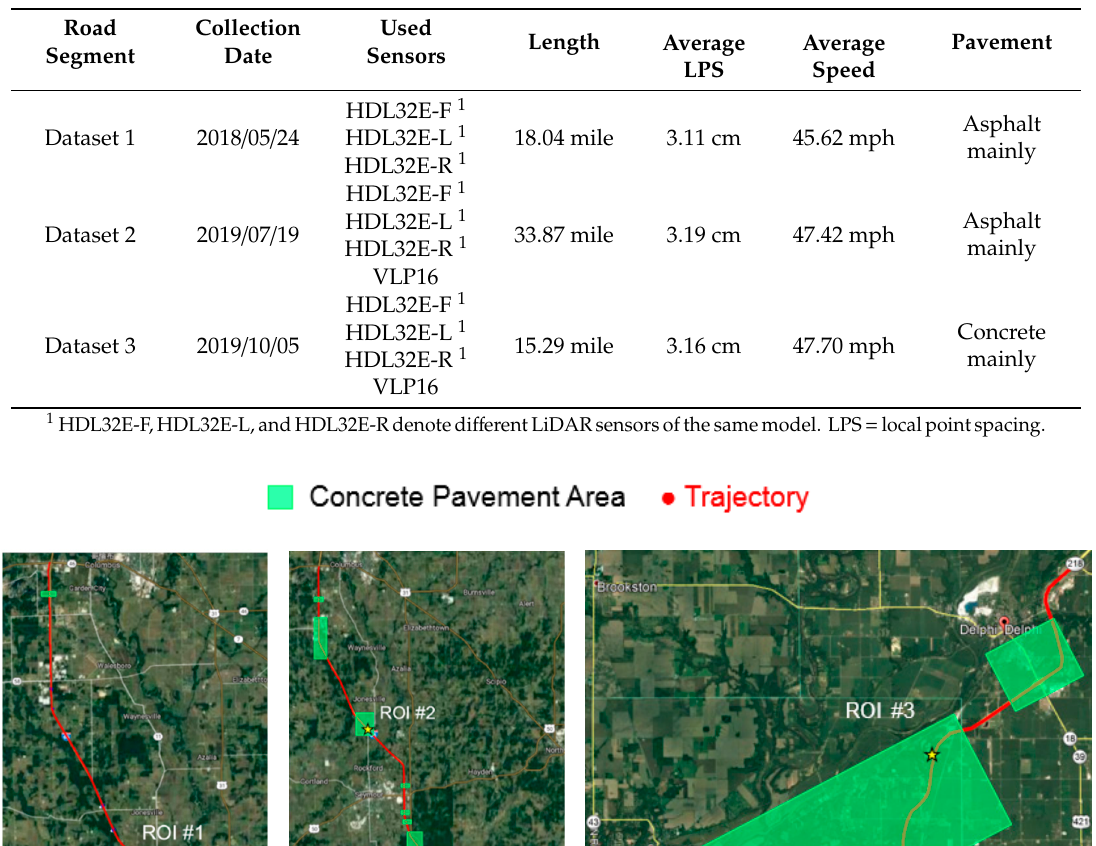
Table 2. Description of the three LiDAR-based mobile mapping systems (MMS) point clouds.